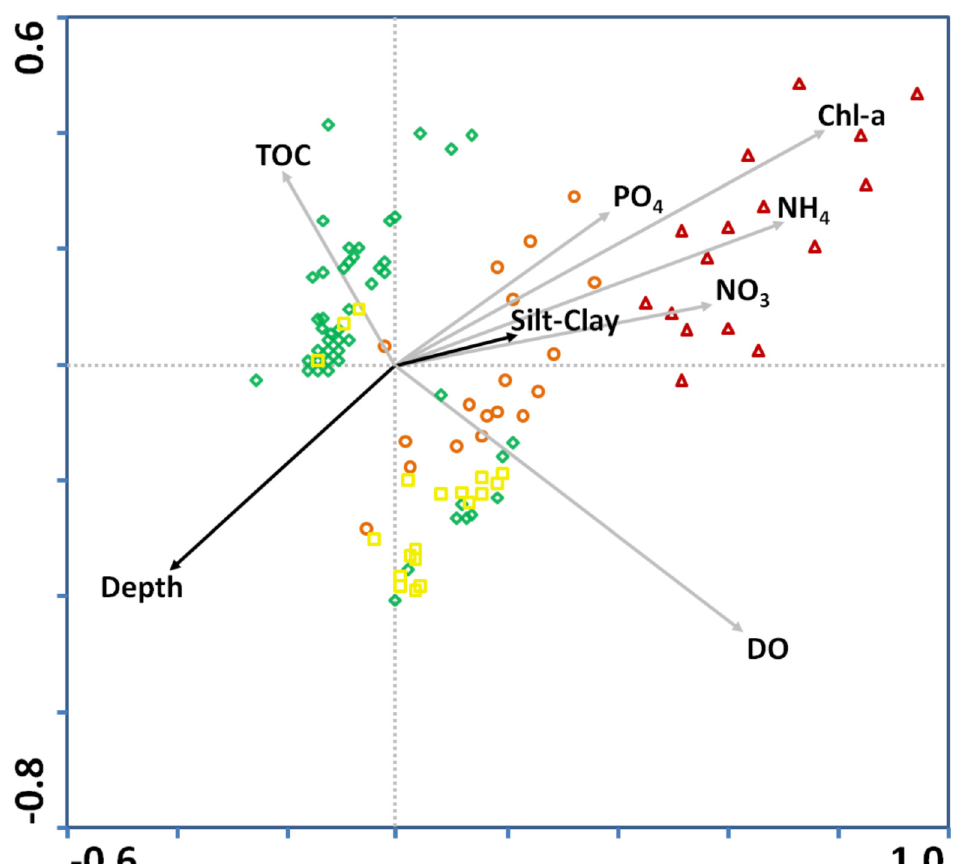
Fig 5. Canonical Correspondence Analysis biplot with stations and environmental variables. Stations are labeled after the Ecological Status defined by means of the Benthic Quality Index — Family index: Symbols indicate Ecological Status: triangle, Bad; circle, Poor; square, Moderate; diamond, Good.